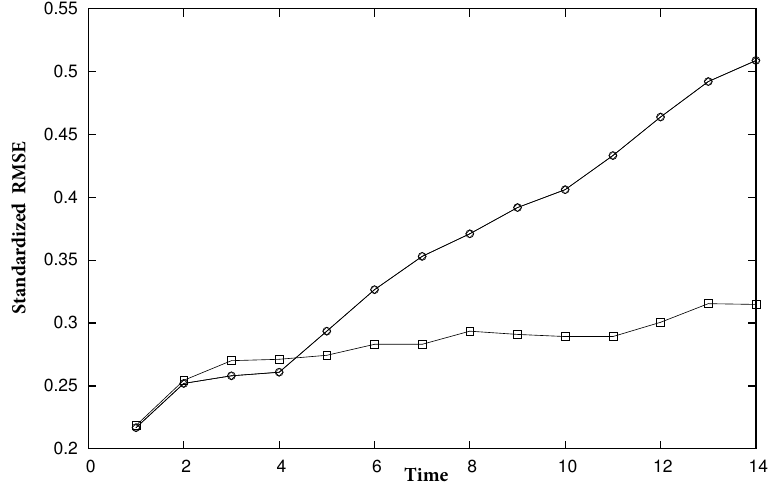
Figure 12. Prediction errors for coop1 using nonlinear methods.